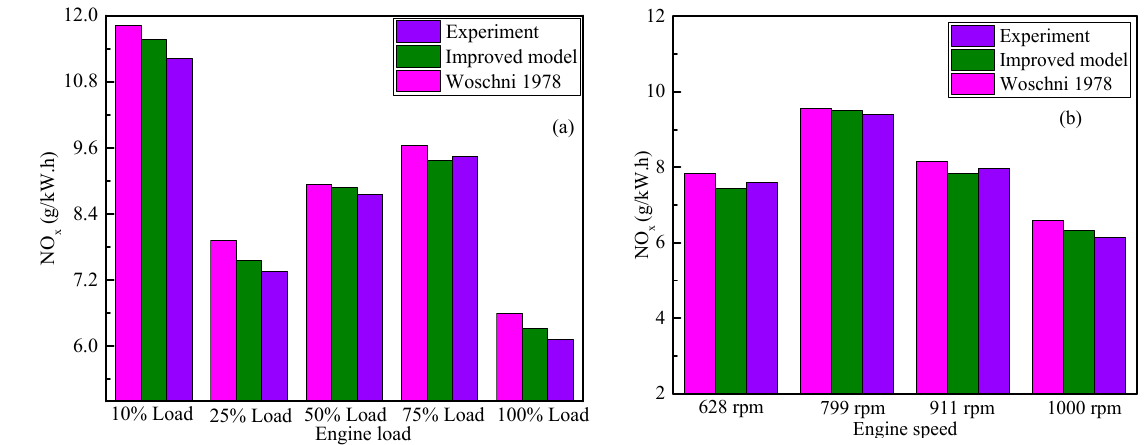
Figure 8. Comparisons of NO x emission under different load conditions.